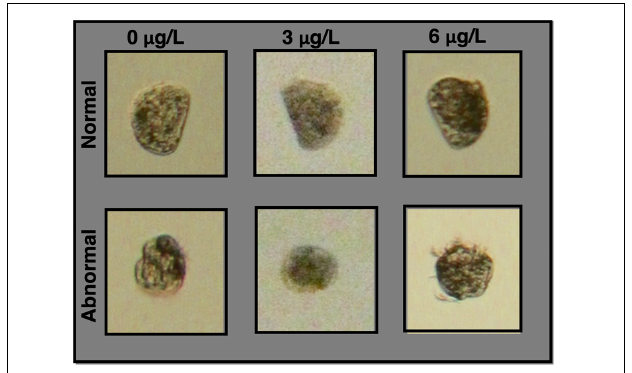
FIGURE 1 | Images of normal and abnormal larvae at each copper concentration. Normal animals are morphologically very similar for all copper concentrations, and were characterized by standard features of larvae that have reached the D-veliger stage – a straight hinge on one side of the organism, and a regular convex curve extending out from the hinge. More variation was observed in abnormal larvae, but key defining features were round and/or irregular